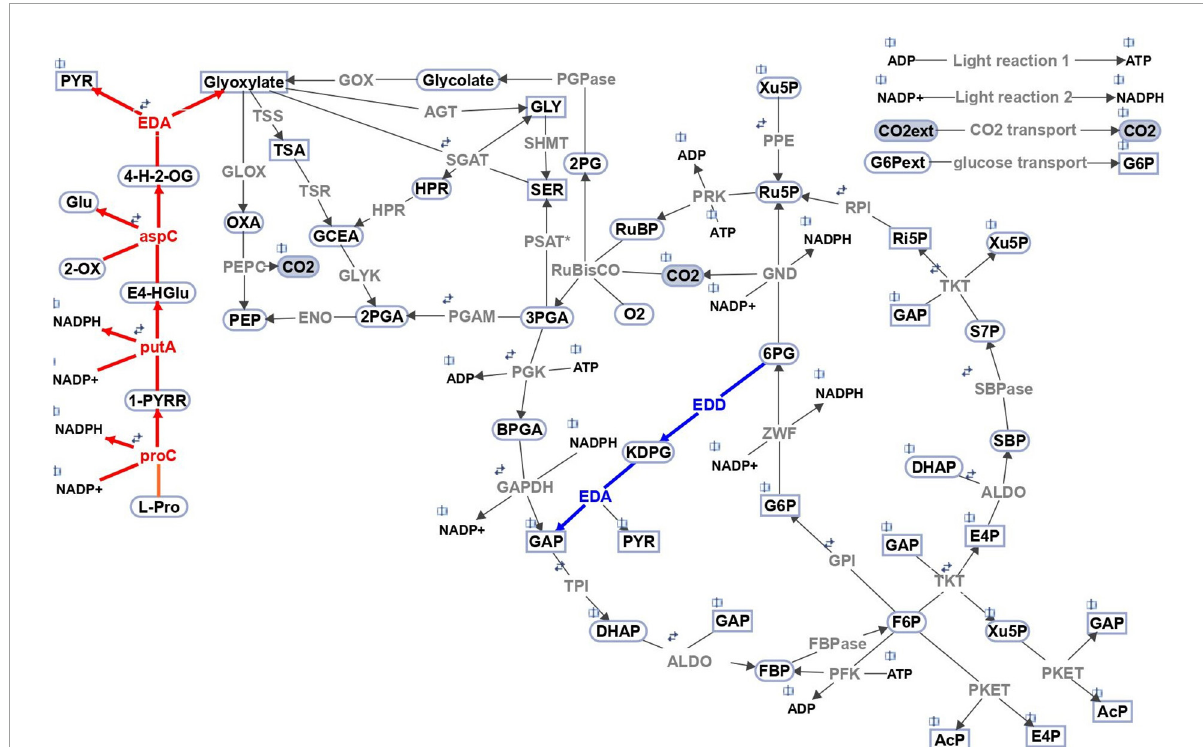
FIGURE1 Schematic representation of the central carbon metabolism network implemented in the multi-level kinetic model of Synechocystis sp . PCC 6803. The blue highlights the reactions of the Entner-Doudoroff pathway. Red indicates the proposed secondary role or EDA and related pathway to proline; annotated gene IDs are included for the convenience. The model includes the Calvin-Benson cycle, glycogen synthesis (sink from glucose-6-phosphate), photorespiratory pathways, phosphoketolase pathway, glycolysis, the oxidative pentose pathway, Entner–Doudoroff pathway, and sink reactions (representing the adjacent pathway and the calculation of biomass production, indicated by metabolites in rectangular shapes). The reversibility of a particular reaction is indicated by two small arrows. Gray indicates the involved enzymes: RuBisCO , ribulose-1,5-bisphosphate carboxylase oxygenase; PGK , phosphoglycerate kinase; GAP , glyceraldehyde-3-phosphate dehydrogenase; TPI , triose-phosphate isomerase; ALDO, aldolase; FBPase , fructose-1,6 bisphosphatase; PFK , phosphofructokinase; TKT , transketolase; SBPase , sedoheptulose-1,7 bisphosphatase; RPI , phosphopentose isomerase; PPE , phosphopentose epimerase; PRK , phosphoribulokinase; GPI , glucose-6-phosphate isomerase; G6PD , glucose-6-phosphate dehydrogenase; PGD ,